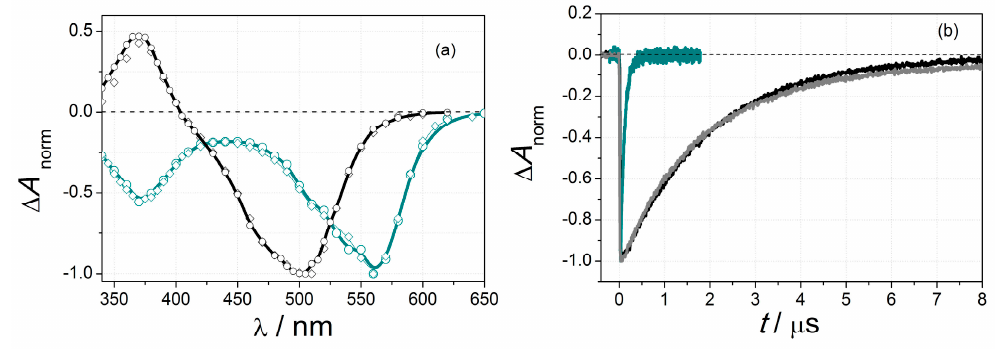
Figure 4. ( a ) Normalized transient absorption spectra recorded directly after laser excitation at 532 nm (MeOH; T = 298 K; I exc ≈ 3 mJ; fwhm ≈ 9 ns): [FeL] 2+ (OD 532 = 0.36; black) and [Fe(tren)py 3 ] 2+ (OD 532 = 0.15; green); additional data recorded in MeCN are given as square symbols; ( b ) transient decay profiles recorded at 500 nm for [FeL] 2+ (black: MeOH; grey: MeCN) and at 560 nm for [Fe(tren)py 3 ] 2+ (green).